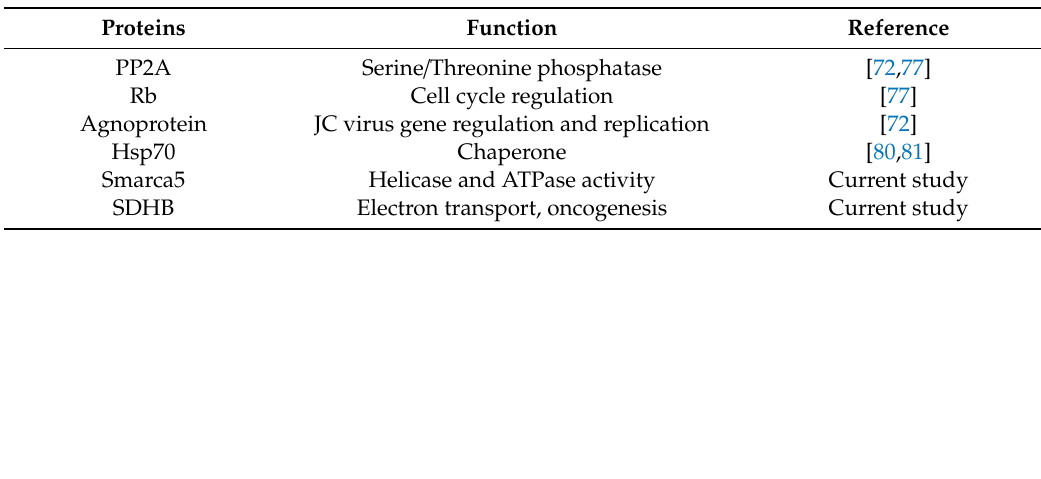
Table 1. Currently and previously reported host proteins that interact with JCV Sm